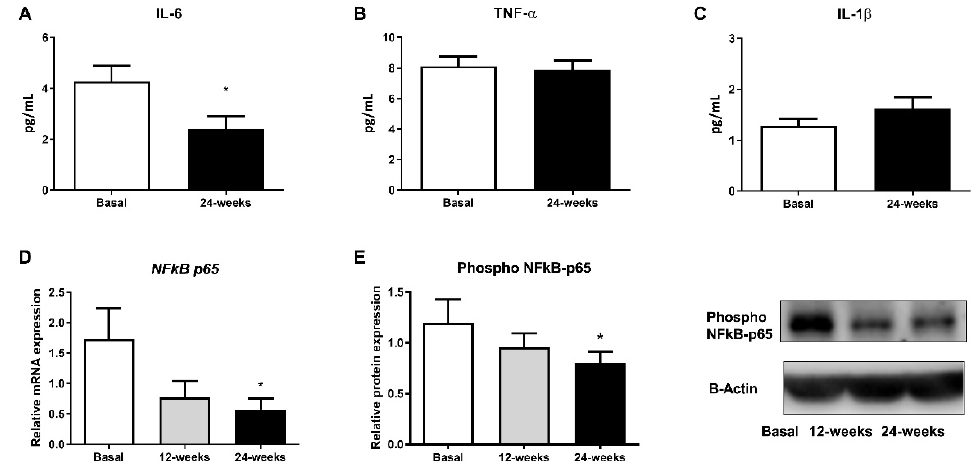
Figure 3. Effects of empagliflozin treatment on serum levels of pro-inflammatory cytokines IL-6, TNF- α , and IL-1 β , as well as production and expression of NF κ B-p65, in leukocytes from T2D patients at baseline and at 12 and 24 weeks of treatment. Serum levels of ( A ) IL-6, ( B ) TNF- α , and ( C ) IL-1 β , ( D ) mRNA expression of NFkB-p65, and ( E ) protein levels of phospho NF κ B-p65, representative WB images in human leukocytes. Data are expressed as mean ± SEM. The values of NFkB-p65 gene expression were normalized to mean baseline mRNA expression levels and calculated using the 2 − ∆∆ CT method. For mRNA expression of NFkB-p65, a paired Student’s t-test was performed. * p < 0.05 vs. baseline. Abbreviations: IL, interleukin; NF κ B-p65, nuclear factor kappa-light-chain-enhancer of activated B cells; TNF- α , tumor necrosis factor alpha.